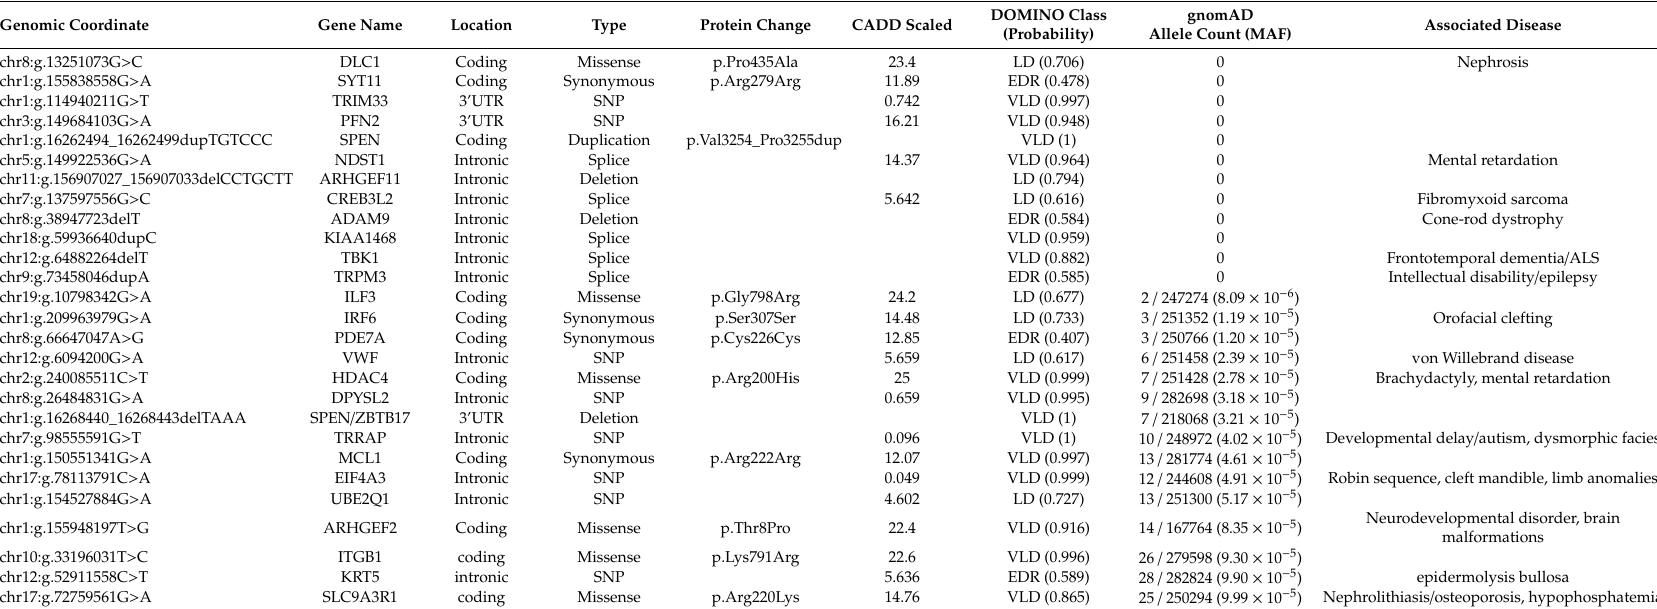
Table 1. Shared variants identified by exome sequencing. From the original list of 411 shared variants, further filtering based on DOMINO class consistent with a dominant mode of inheritance and minor allele frequency of less than 1 × 10 − 4 . (VLD = very likely dominant; LD = likely dominant; EDR = either dominant or recessive). Note: Allele count and minor allele frequency (MAF) were determined from the gnomAD database (June,